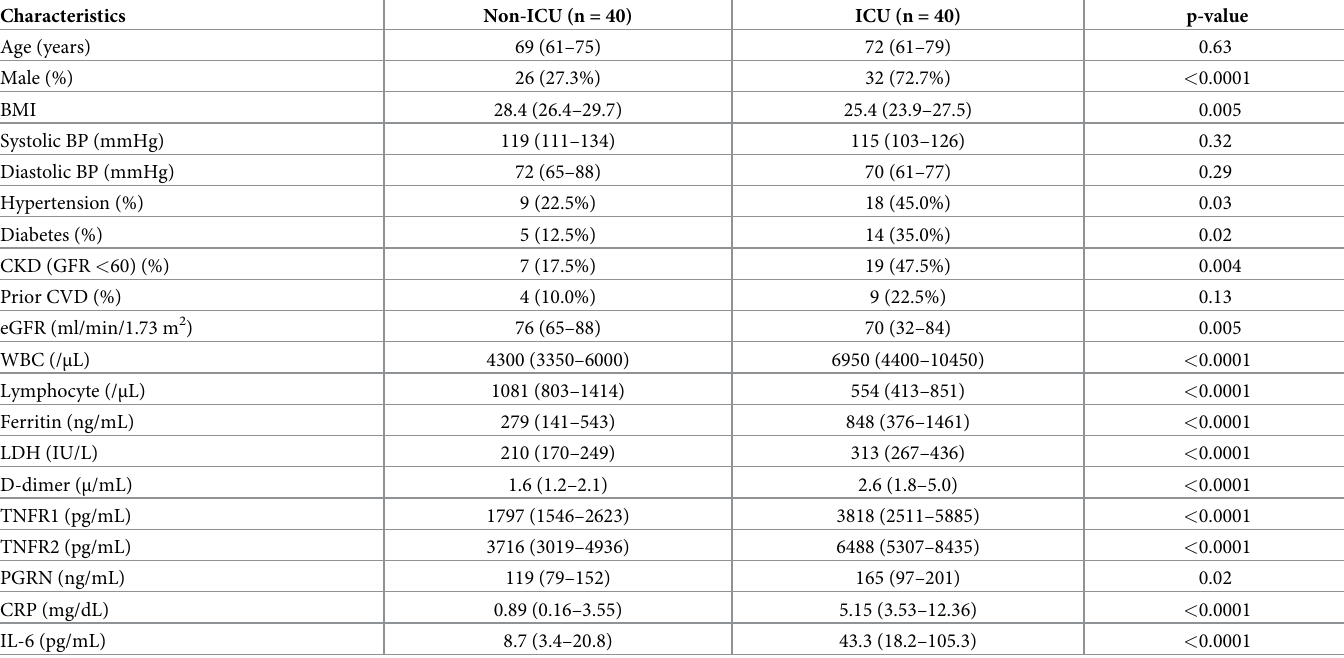
Table 1. Clinical characteristics and inflammatory markers related to disease severity at the time of admission. Characteristics